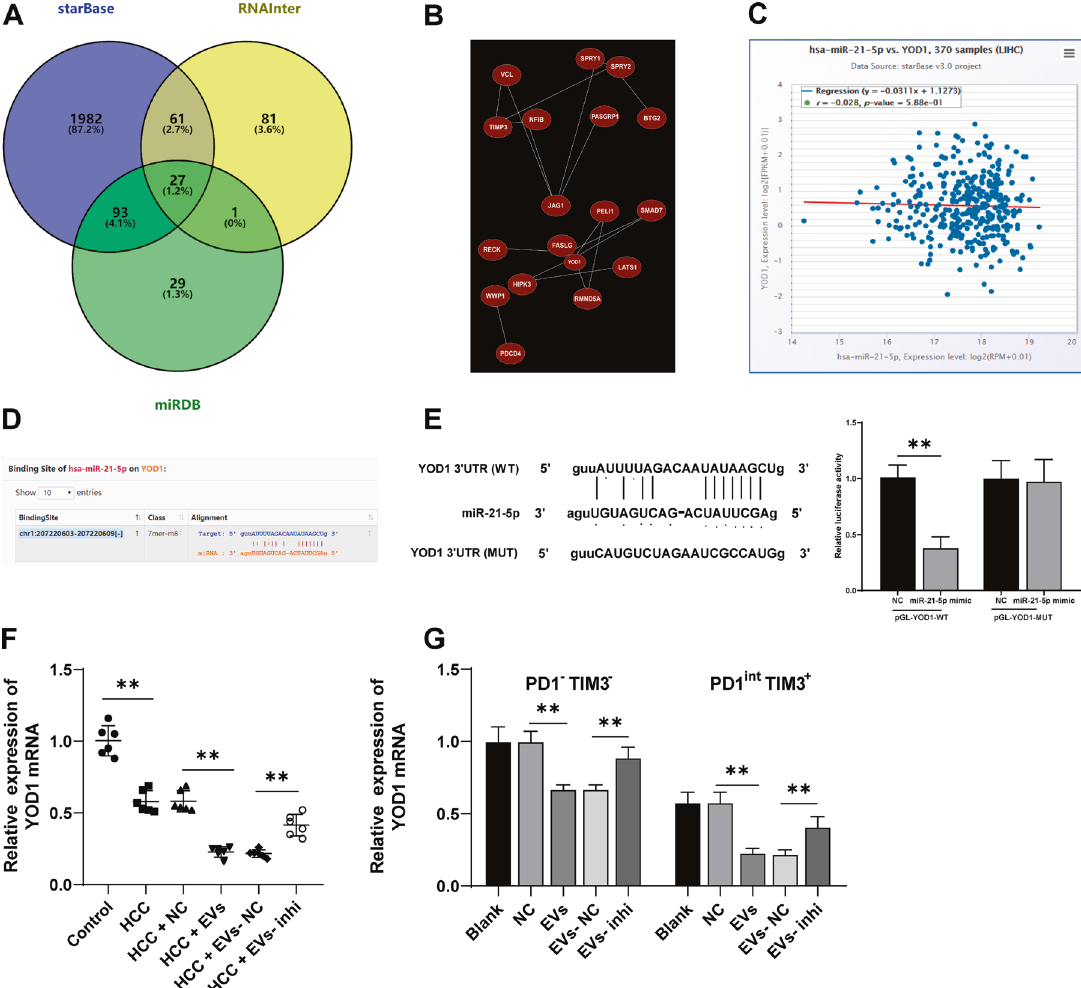
expressions of miR-21-5p and YOD1 was analyzed through the ECORI Pan-Cer database. D The targeting relationship between miR-21-5p and YOD1 was predicted through the StarBase database. E The targeting relationship between miR-21-5p and YOD1 was veri fi ed using a dual- luciferase assay. F , G YOD1 mRNA expression in mouse liver ( F ) and CD8 + T cells ( G ) was detected using RT-qPCR. N = 6. The cell experiment was repeated 3 times. Data are presented as mean ± standard deviation and analyzed using one-way ANOVA, followed by Tukey ’ s multiple comparison test, ** p <